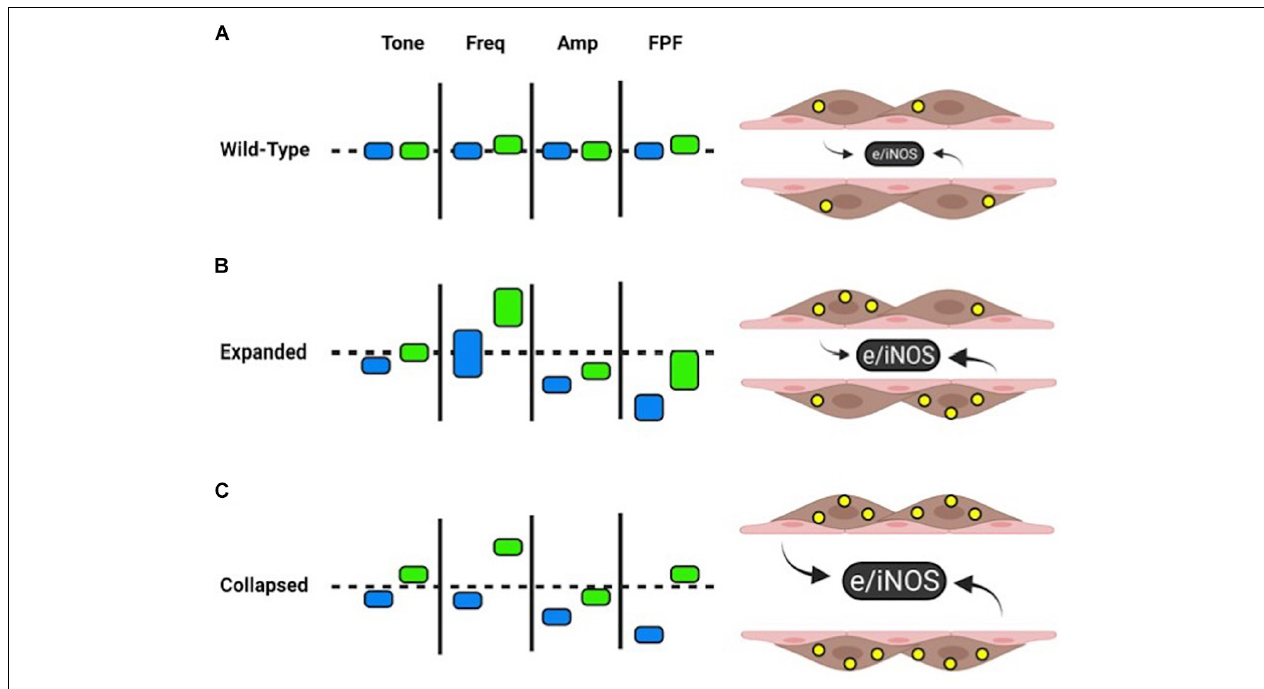
FIGURE 5 | Summary of WT and TNF-Tg contractility with and without L-NAME. Wild-type PLVs exhibit homeostatic NOS (produced by pink LECs ex vivo ) and NO levels (yellow circles within brown LMCs). L-NAME (green rectangles) leads to slight increases in FREQ and FPF from baseline (blue rectangles). Approximate changes are demonstrated by vertical movement up (increased) or down (decreased) of the rectangles (A) . Relative to wild-type baselines (dashed line), expanded TNF-Tg PLVs have similar tone, increased variability of FREQ (vertical length of rectangle), reduced AMP, and reduced FPF. L-NAME shows an increased trend in all measures of contractility, while FREQ and FPF exhibit notable variability between expanded TNF-Tg PLVs (B) . PLVs from collapsed TNF-Tg mice showed comparable effects to expanded TNF-Tg PLVs, but with uniform measures of FREQ and FPF. L-NAME dramatically increased tone, FREQ, and FPF to wild-type levels or above (C) . For all groups, L-NAME treatment stabilized FPF to baseline levels primarily associated with increased FREQ of TNF-Tg PLVs. Given the variability of FREQ in expanded TNF-Tg PLVs, as a group this stage of disease may be less dependent on NOS inhibition to recover FPF compared to collapsed TNF-Tg PLVs with more consistent FREQ responses. Created with